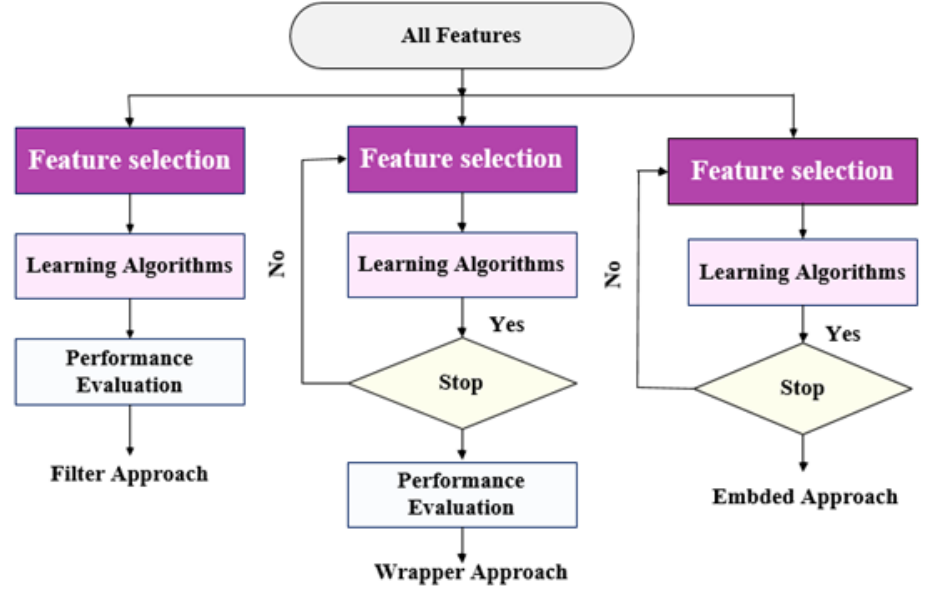
Figure 2. The different types of feature selection